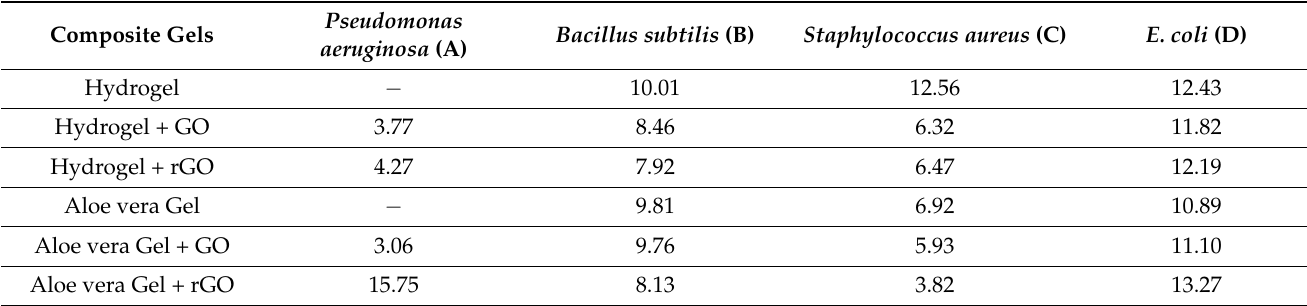
Table 1. Zone of Inhibition (in mm) for the Agar Well diffusion antibiotic sensitivity assay.